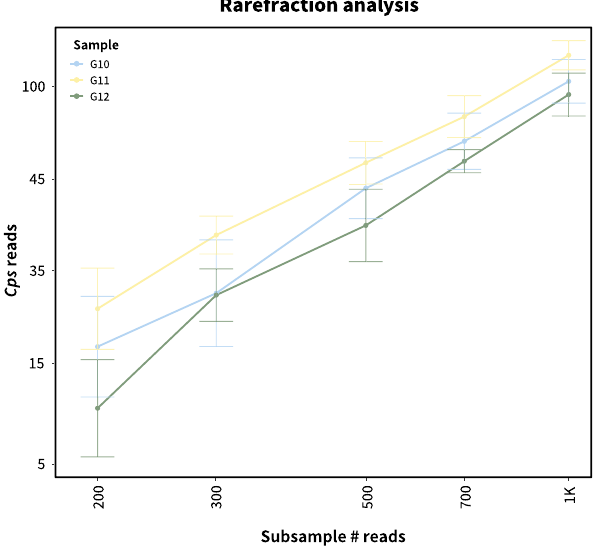
Figure 5. Detection limit analysis based on computational sub-sampling. Sub-samples were obtained by randomly extracting reads from original sequencing files. The X-axis shows the number of sub-sampled reads. The Y-axis shows the number of identified Cps reads. The circles represent the median value for each sub-sample size and error bars show the standard deviation among the 10 subsampling